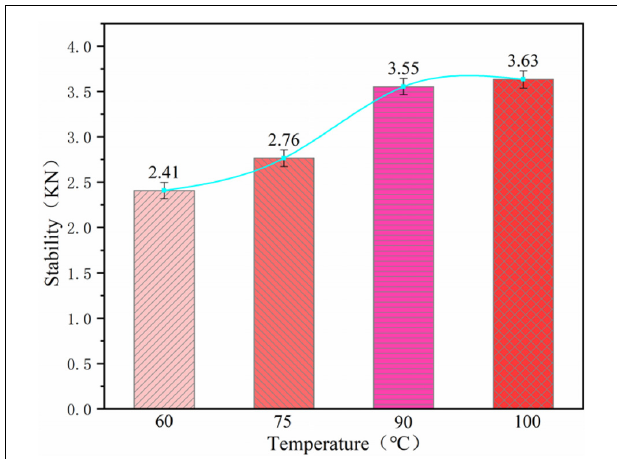
FIGURE 2 | Stability of CPAM under different curing temperatures.